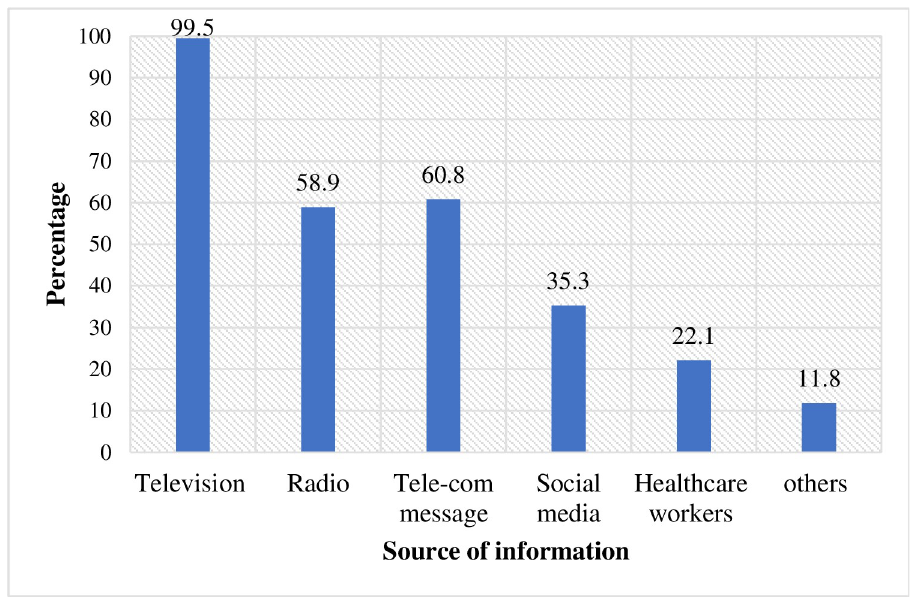
Fig 1. Source of information about COVID-19 among waiters working in food and drinking establishments in Southwest Ethiopia, 2020 (n = 416).